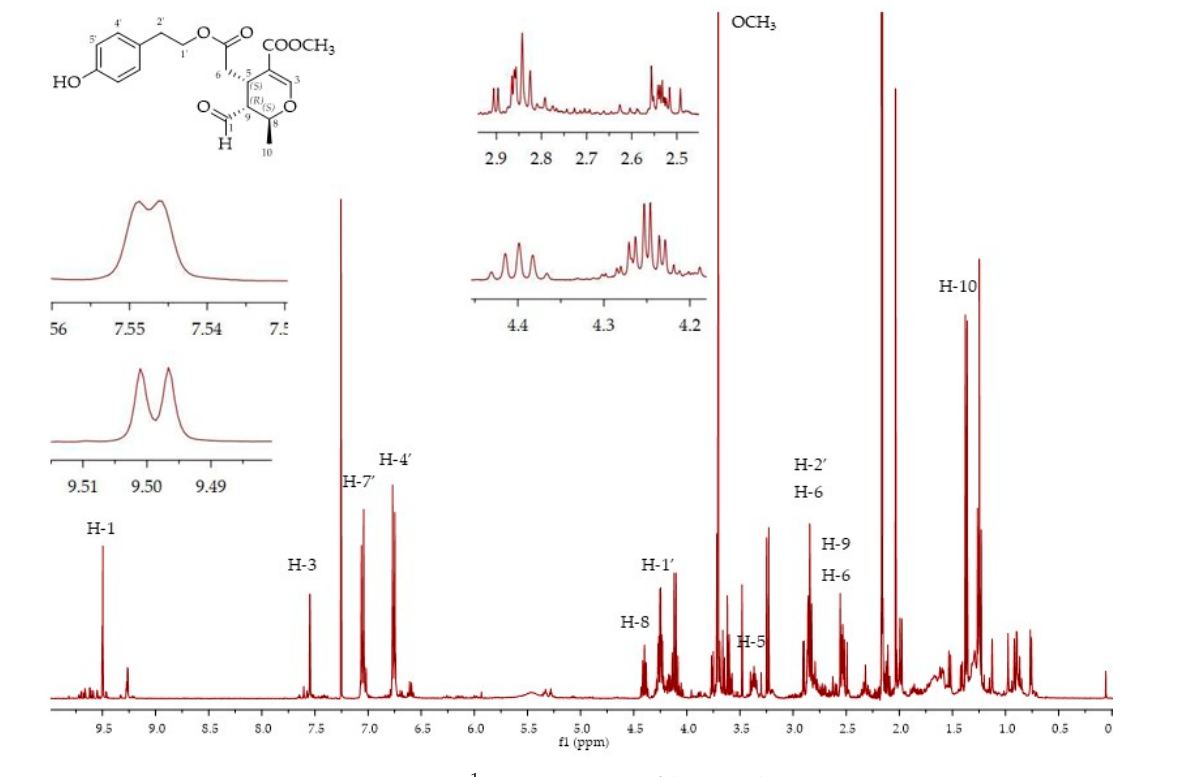
1 H NMR spectra of (5 S ,8 R ,9 S )- 7 . Figure 4. 1 HNMR spectra of (5 S ,8 R ,9 S )- 7 . Figure 4. 1 HNMR spectra of (5 S ,8 R ,9 S )- 7 . Figure 4.